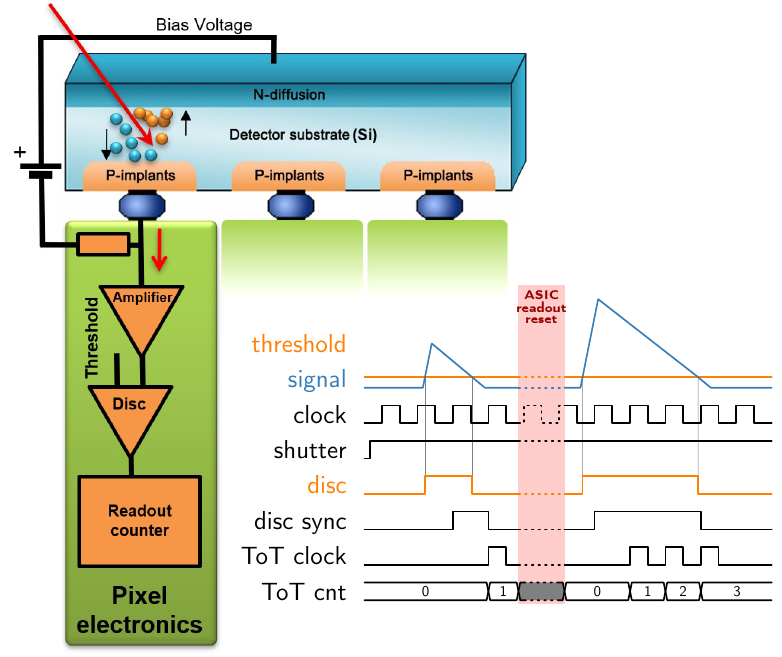
Figure 1. Schematic representation of Timepix3 detector function in Time-over-Threshold